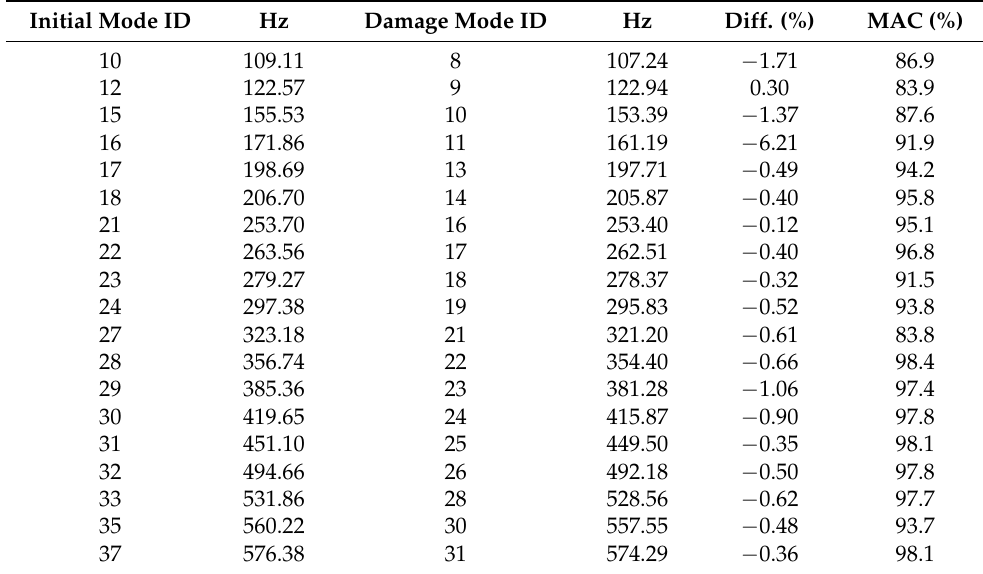
Table 2. List of correlated mode pairs (MAC > 80%), for 40 kN damage load.